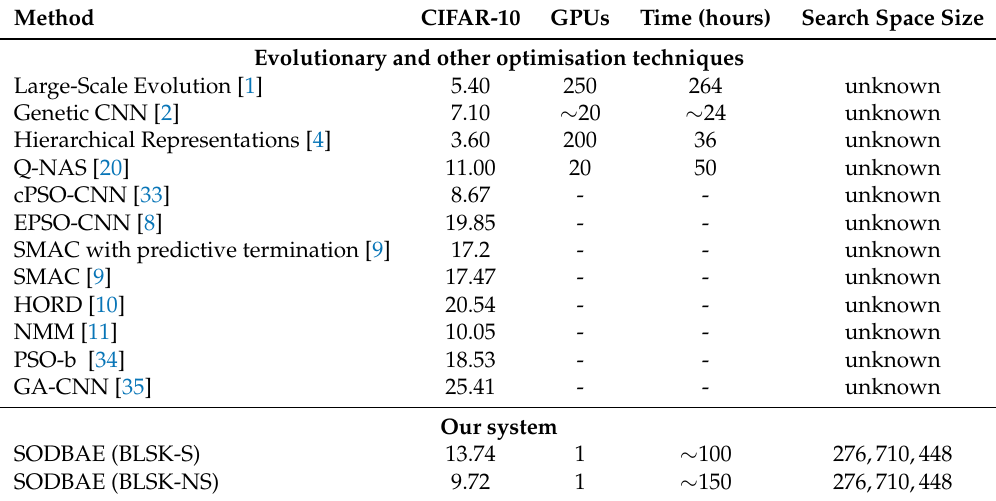
Table 5. Classification error rates (%) for the proposed SODBAE model and other related studies for the CIFAR-10